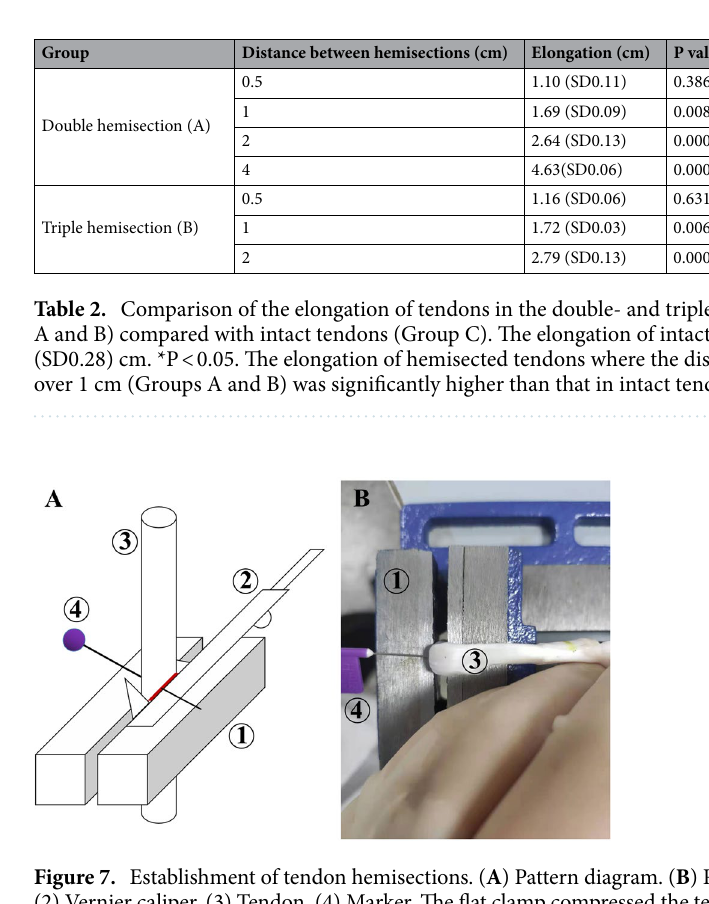
Figure 7. Establishment of tendon hemisections. ( A ) Pattern diagram. ( B ) Realistic operation. (1) Flat clamp. (2) Vernier caliper. (3) Tendon. (4) Marker. The flat clamp compressed the tendon along the hemisection plane, and the cross-sectional area of the tendon was approximately rectangular. The width of the area on the contact side was measured with a clamp using a Vernier caliper. A marker was inserted at the midpoint of the width. Subsequently, a surgical blade was used to cut the tendon perpendicular to the clamped surface. When the midpoint was reached, the marker